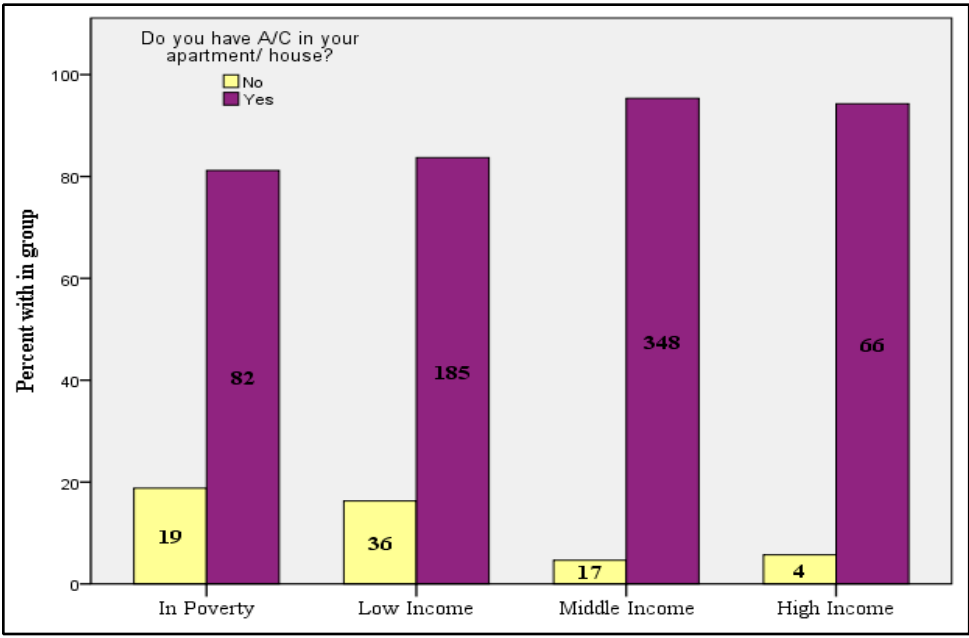
Figure 5. Access to air conditioning (A/C) devices across different income groups. The numbers inside the bars represent the number of total respondents in the respective group.